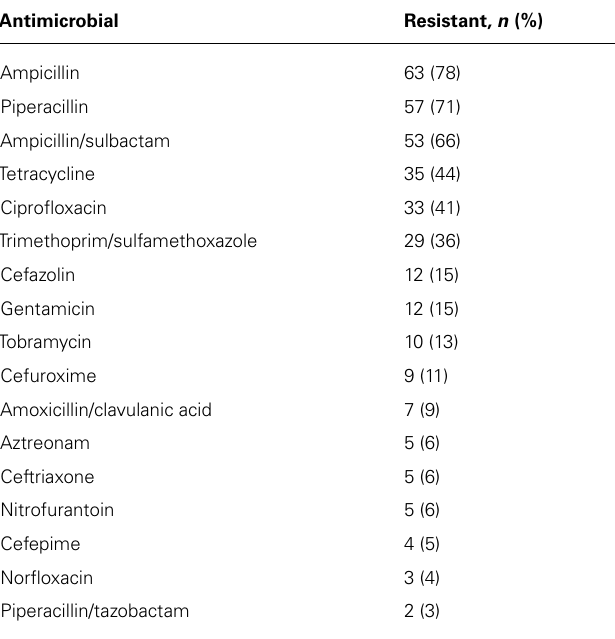
Table 1 | Frequency of the antimicrobial resistance of E. coli strains used in this